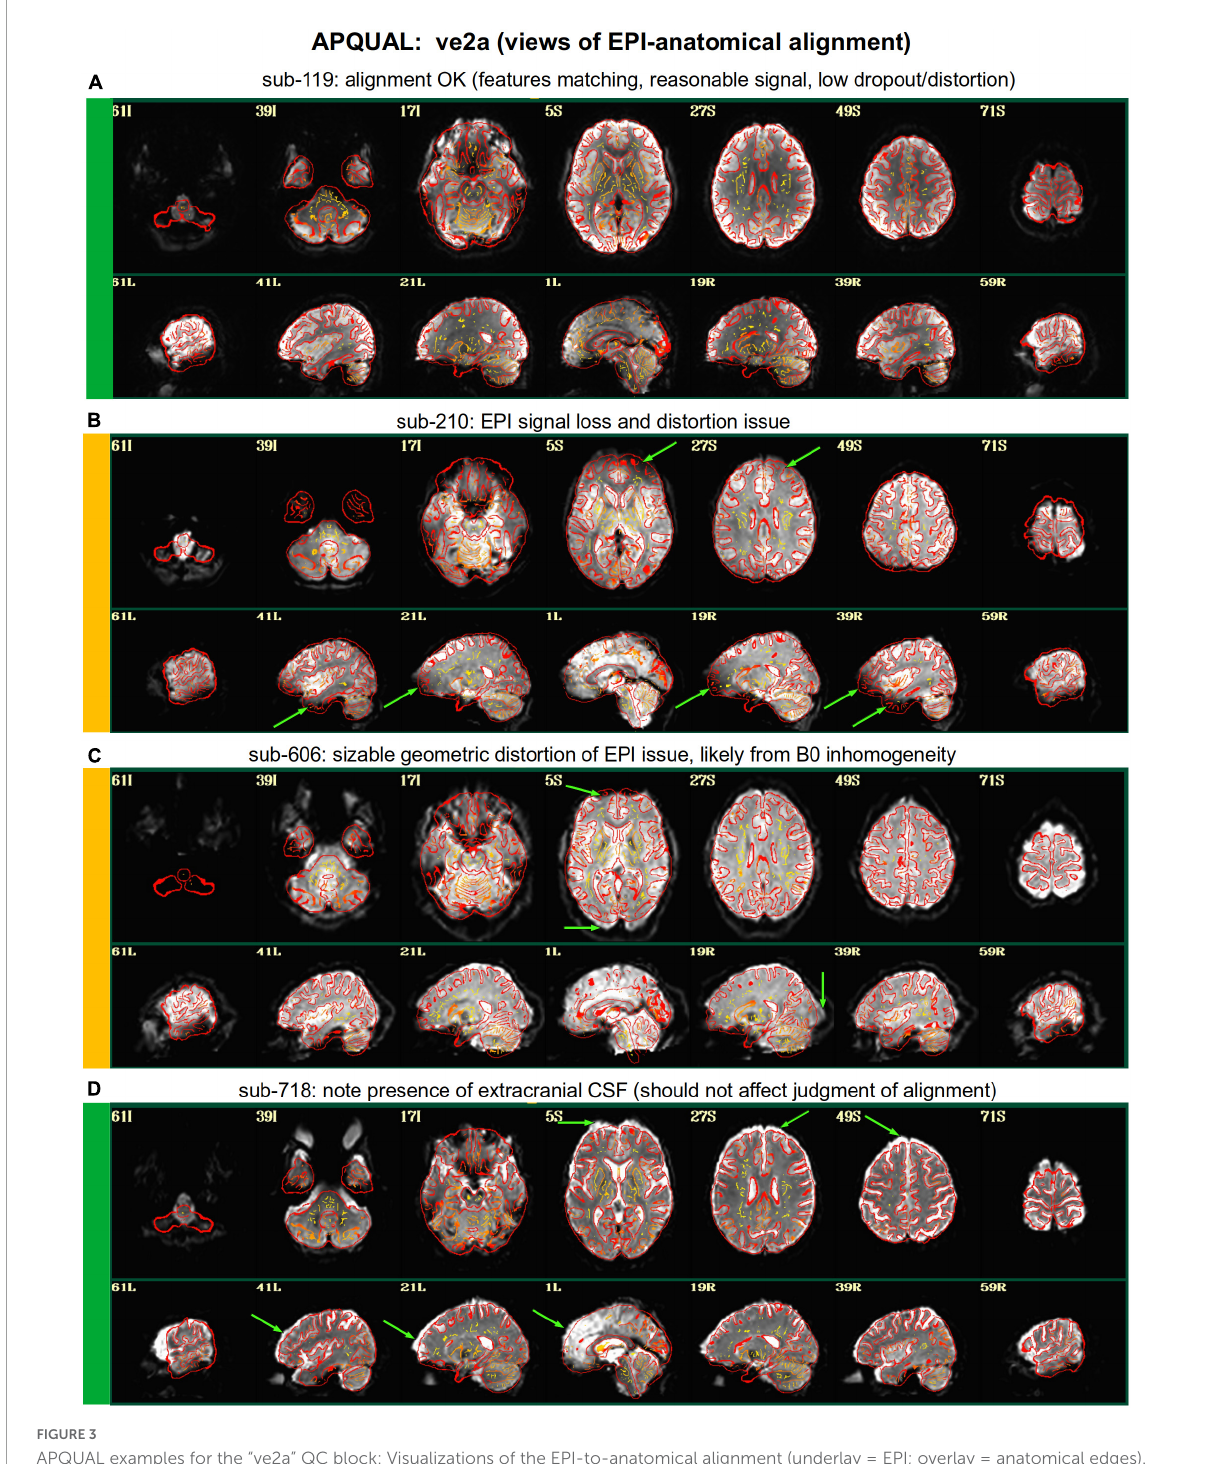
FIGURE3 APQUAL examples for the “ve2a” QC block: Visualizations of the EPI-to-anatomical alignment (underlay = EPI; overlay = anatomical edges). (A) Structures appear generally well-registered. (B) There is notable EPI signal loss in the frontal and subcortical regions. (C) The EPI contains large distortions: Signal pileup in the anterior, and geometric stretching and signal attenuation in the visual cortex. (D) In judging EPI-anatomical alignment, interior structures matter most and CSF (bright, and highlighted with arrows) should be